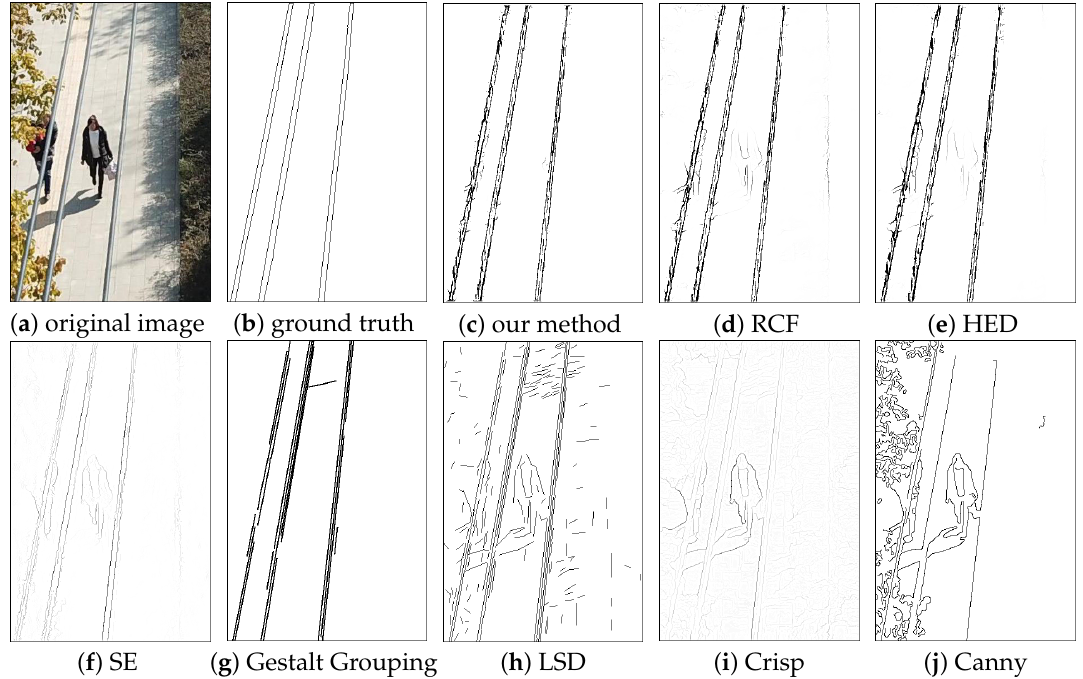
Figure 6. Power line detection results on a sample image from PLDU dataset. From ( a – j ): Original, Ground Truth, Ours, RCF, HED, SE, Gestalt Grouping, LSD, Crisp, Canny.